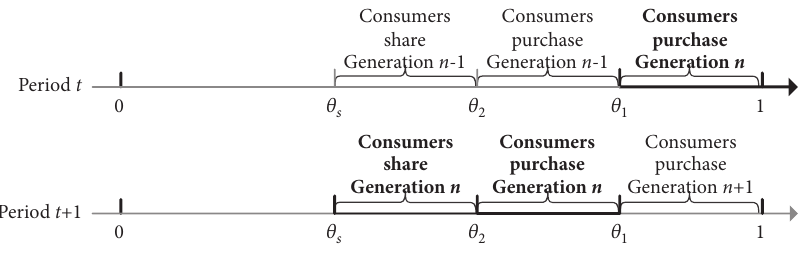
Figure 1: Consumer utilities over two